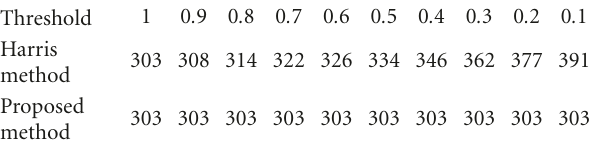
Table 1: E ff ect of threshold on the number of detected points.